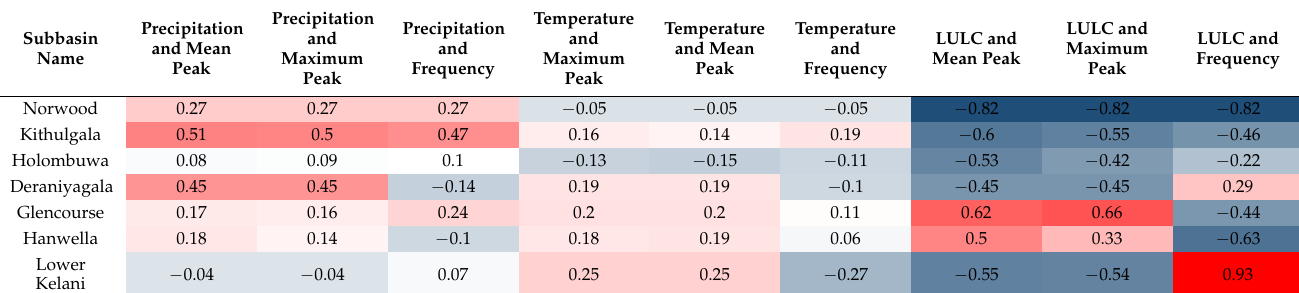
Table 4. Correlation coefficients of climatic factors and LULC for subbasins.